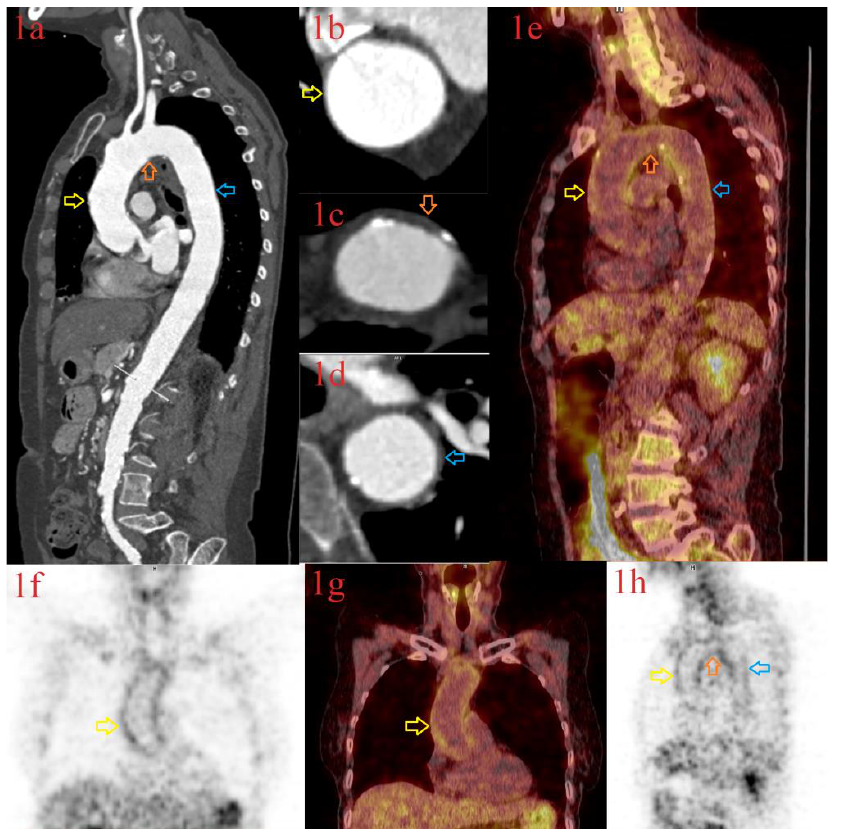
Figure 3. CT aortography (Images ( 1a – 1d )) and Whole-body FDG PET-CT (Images ( 1e – 1h )) in a 63-year-old female with large-vessel vasculitis showing inflammation of the aortic wall at the corresponding levels on the following localization: the ascending aorta (CT: Image ( 1a , 1b ); PET-CT: Image ( 1e – 1h ); red arrows), the aortic arch (CT: Image ( 1a , 1c ); PET-CT: Image ( 1e , 1h ); orange arrows) and the descending thoracic aorta (CT: Image ( 1a , 1d ); PET-CT: Image ( 1e , 1h ); blue arrows).